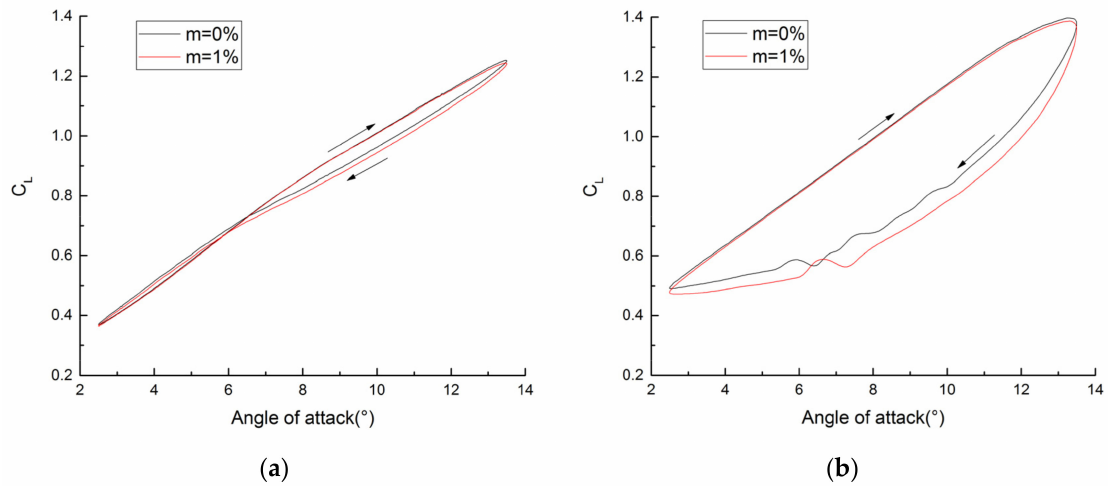
Figure 10. Lift coefficient hysteresis loops of two airfoils for Case 3: ( a ) NACA0012 airfoil; ( b ) S809 airfoil.